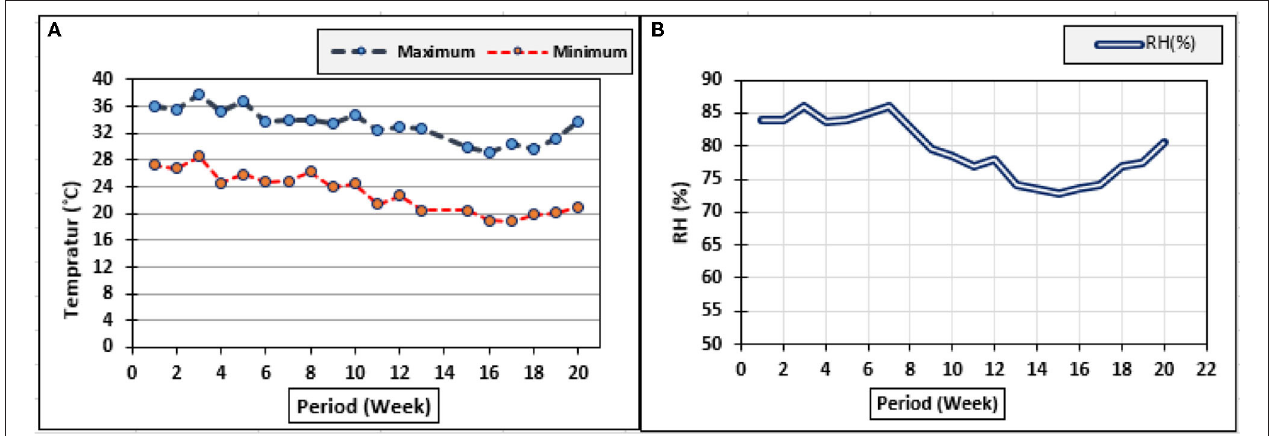
FIGURE 1 | The measured climatic conditions in the greenhouse during 2019 and 2020. (A) Minimum and maximum temperature ( ◦ C); (B) RH (%).